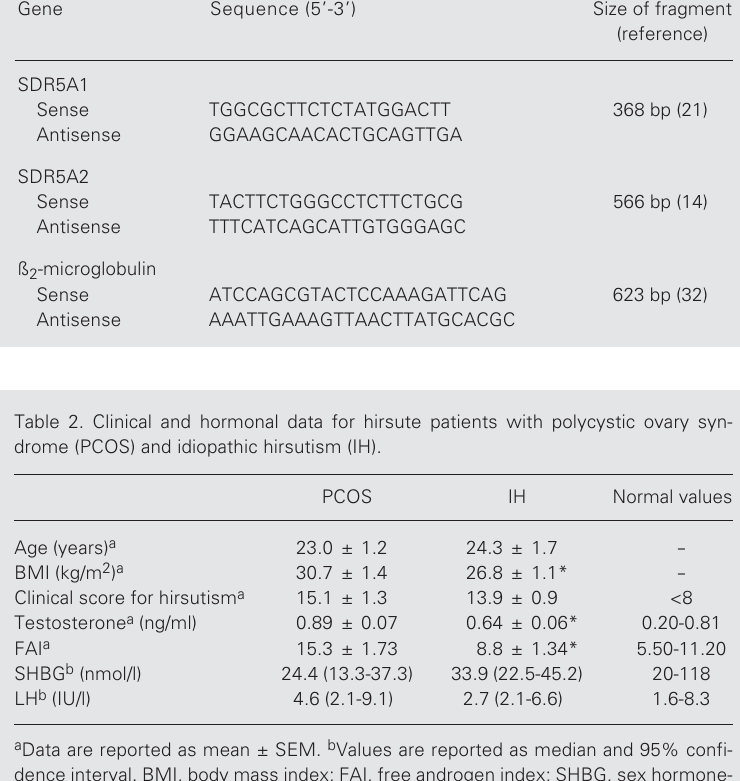
Table 1. Sequence of the primers related to SDR5A1, SDR5A2 and ß 2 -microglobulin cDNA sequences and expected sizes of amplified fragments. Gene